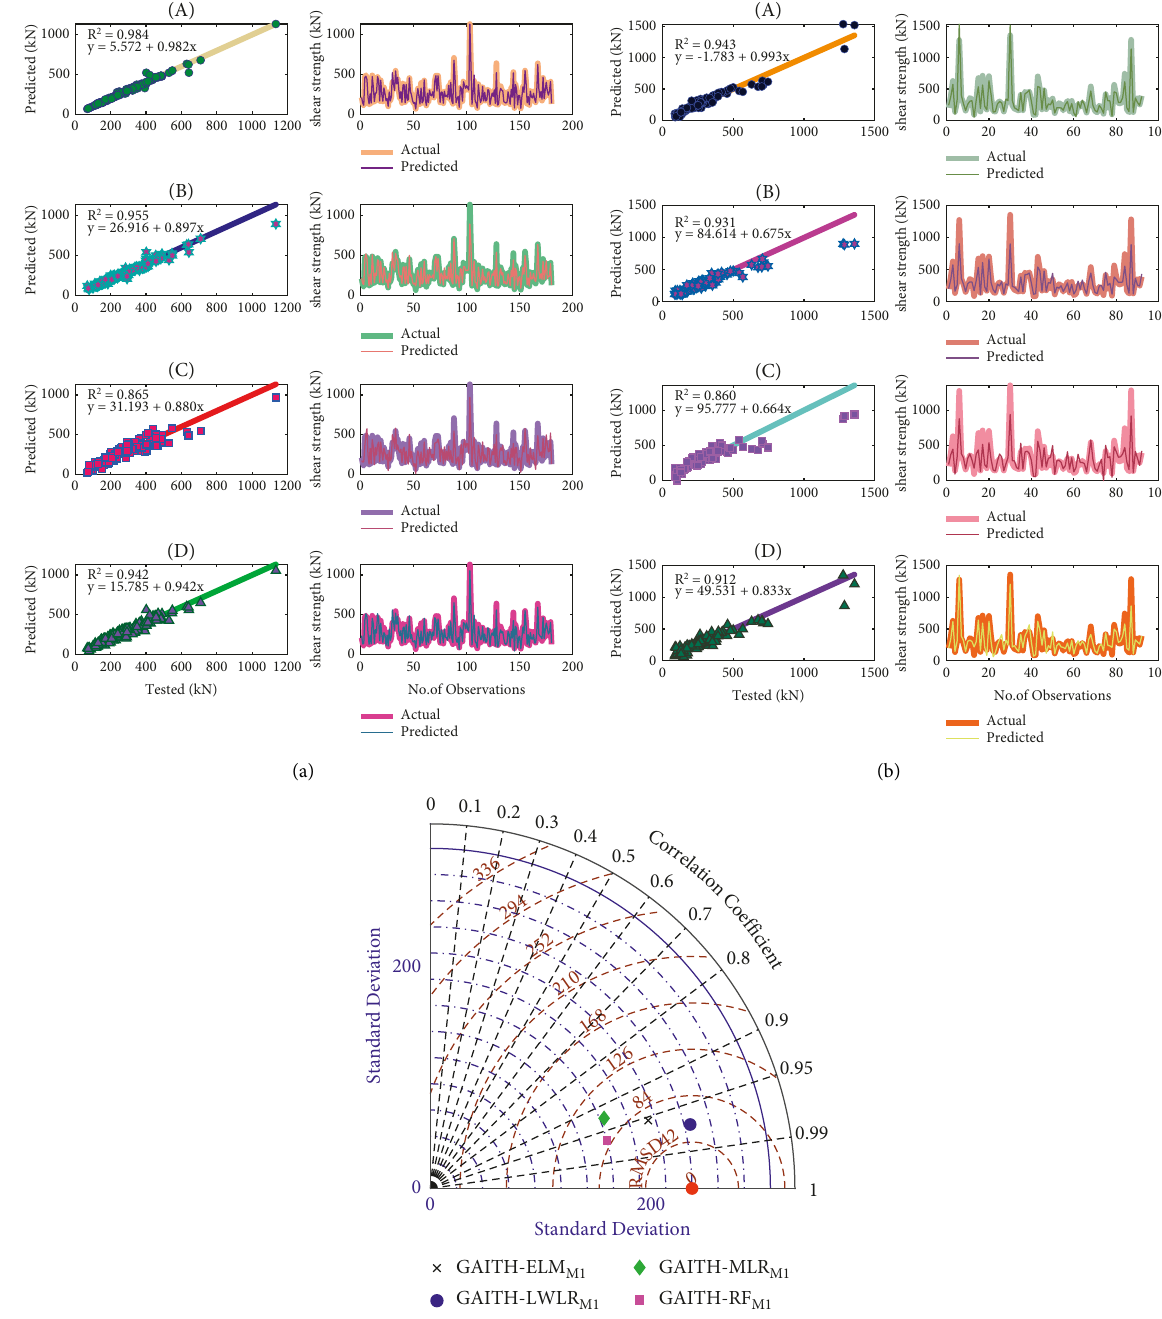
Figure 7: A comparison between the objectives of the models: (A)–(D) represent the GAITH − LWLR , and GAITH − ELM MLR M M 1 models, respectively. Figures (a) and (b) show scatter plots and line plots for the training and test data, 1 respectively, while figure (c) is a Taylor plot based on the test data. (a) Training data. (b) Testing data. (c) Taylor